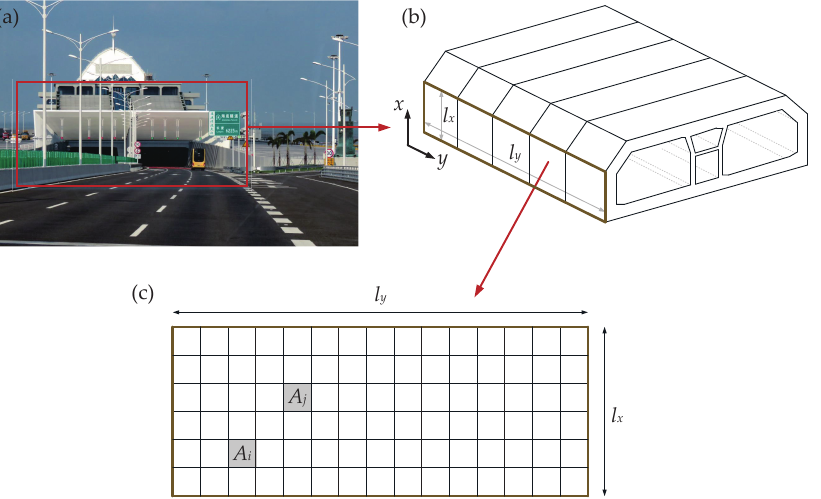
Figure 2. Example of the durability problem. ( a ) The HZM bridge tunnel (source: https://common 4.0 International license). ( b ) A segment of immersed tunnel tube used in the HZM project (after [5]). ( c ) Discretizing the two-dimensional surface into small